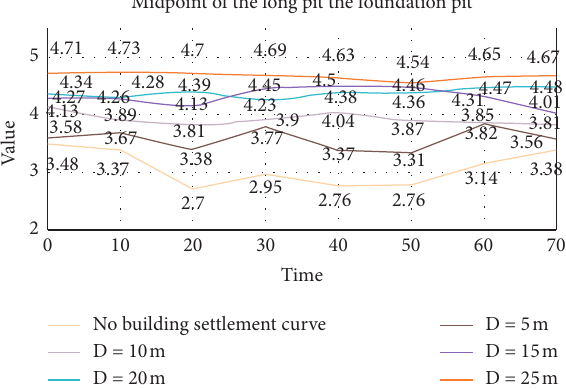
Figure 1: Settlement diagram of frame structure foundation at different distances from the foundation pit Table 1: Settlement difference of adjacent column bases at different distances from the foundation pit wall. Analysis item